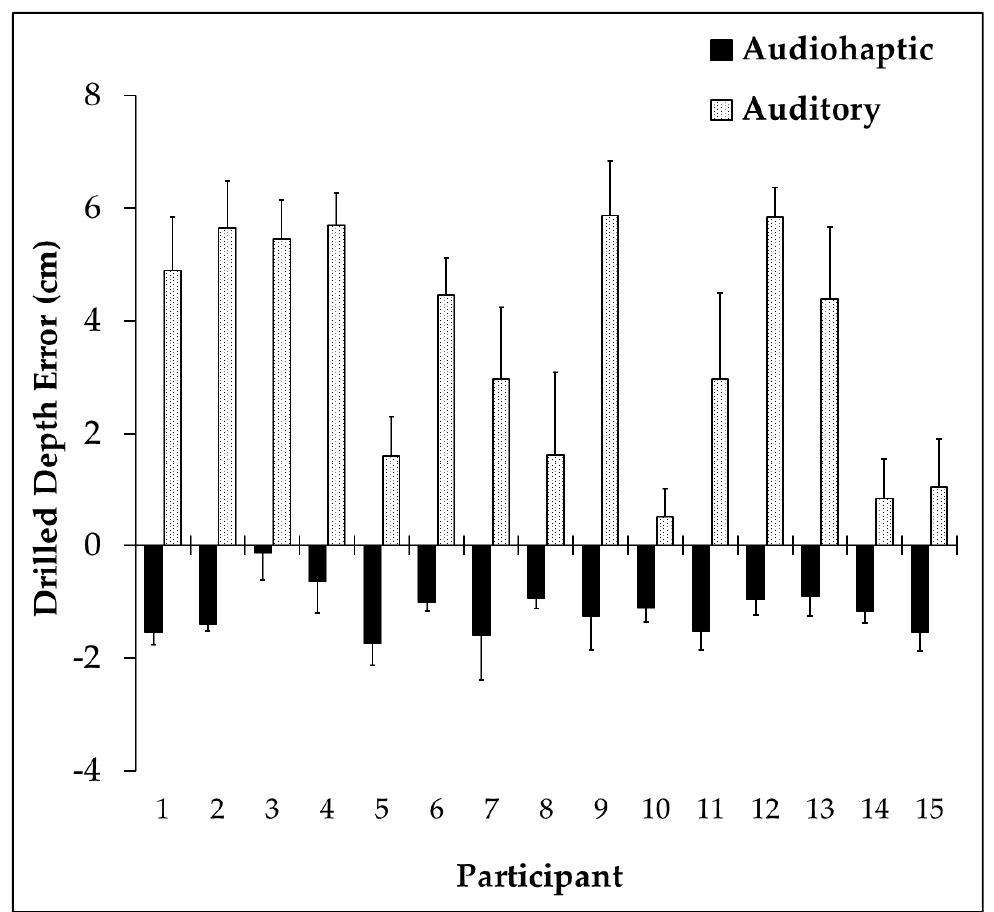
Figure 3. Mean and standard deviation (error bars) of participants’ drilling behavior for each trial type.